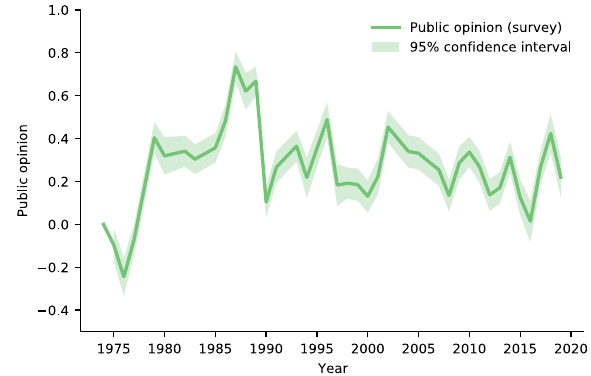
Fig. 1 Public opinion of Americans toward China. This time series is aggregated from 101 cross-sectional surveys from 1974 to 2019 that asked relevant questions about attitudes toward China with the year of 1974 as baseline. Years with attitudes above zero show a more favorable attitude than that in 1974, with a peak of 73% in 1987. Years with attitudes below zero show a less favorable attitude than that in 1974, with the lowest level of − 24% in 1976. The time series is shown with a 95% con fi dence interval.